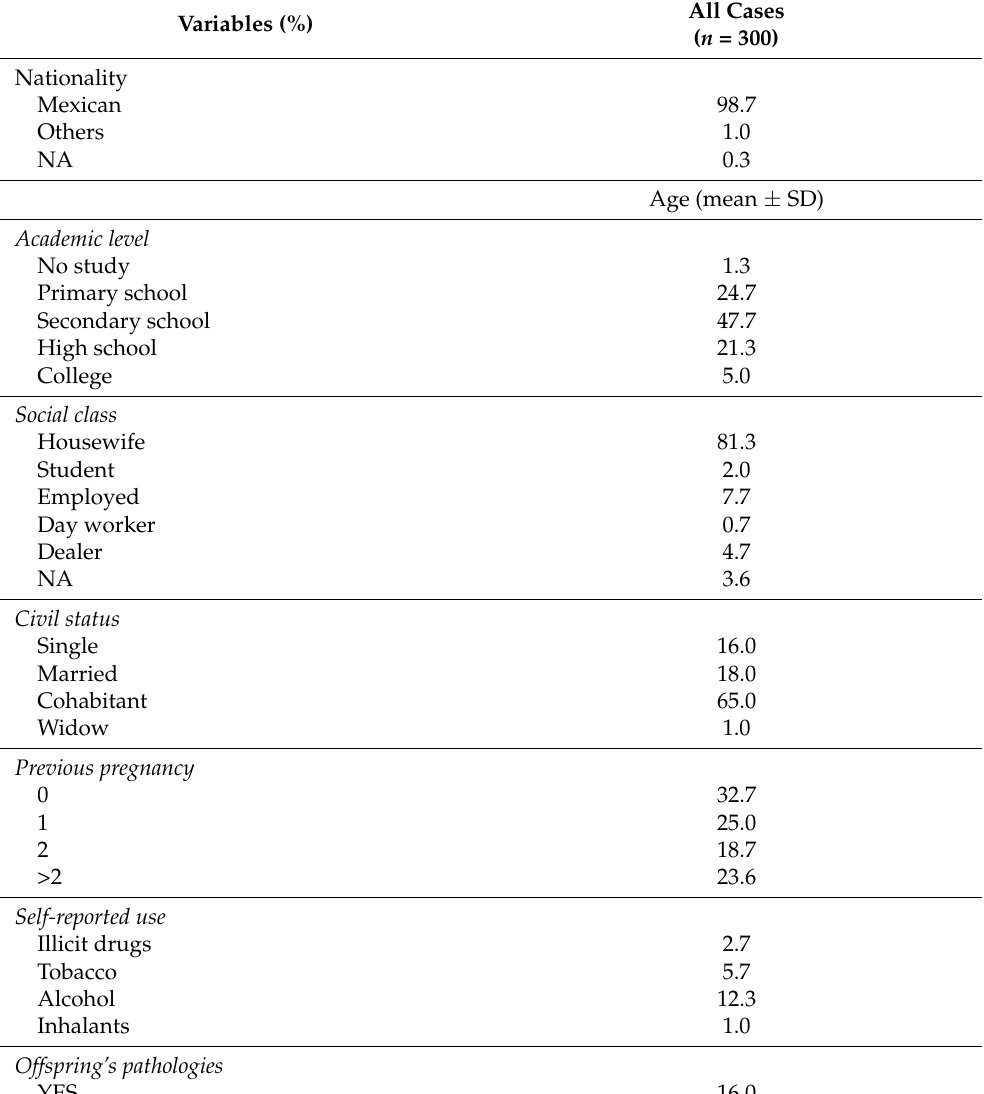
Table 1. Sociodemographic profiles of the women enrolled in the